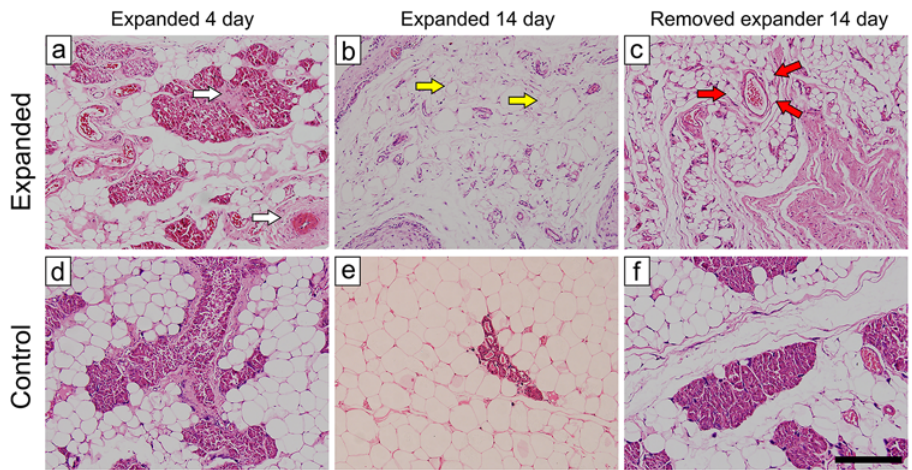
Fig 2. Histology observation of the fat pad. Normal adipocytes were uniform in size and had a normal morphology. During expansion, the growth of connect tissue (white arrow) and the reduced volume of adipocytes (yellow arrow) were observed. After removing the expander, many adipocytes of small sizes and a normal morphology emerged around the new vessels (red arrow). Scale bar = 200 μ